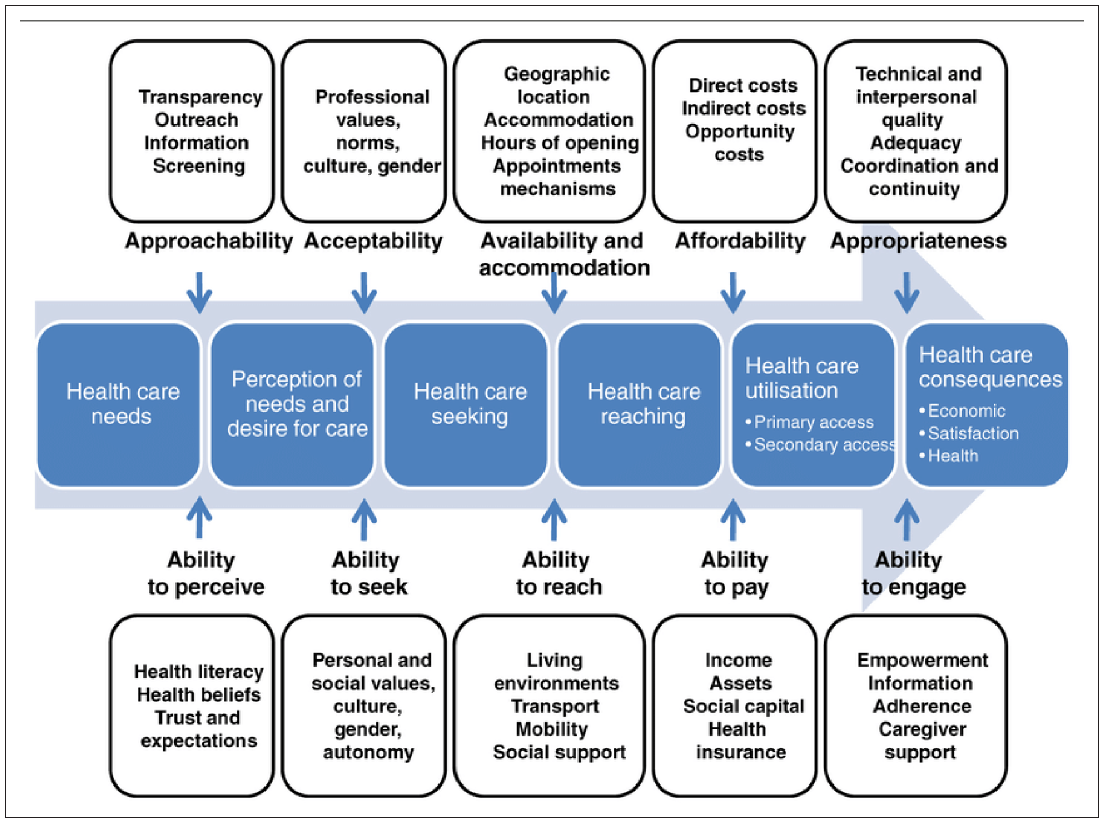
Figure 1 Levesque et al ’s 29 conceptual framework of access to health